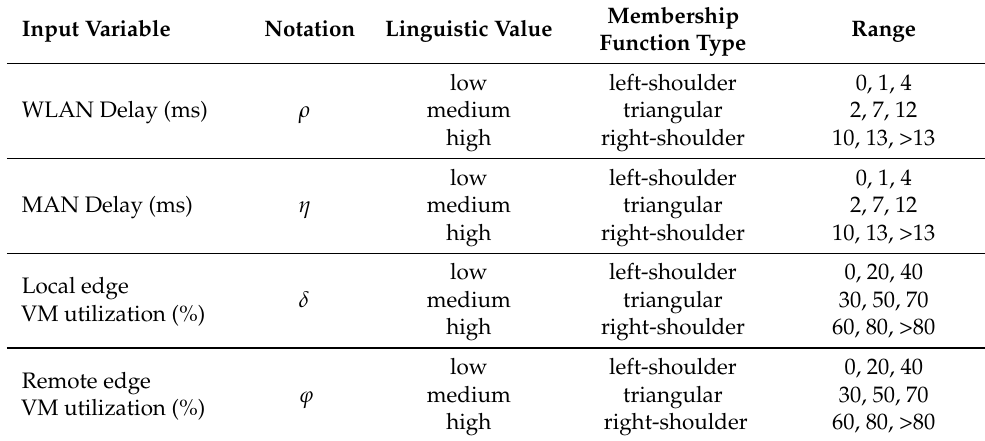
Table 2. Related parameters in the fuzzification of the first FLS.